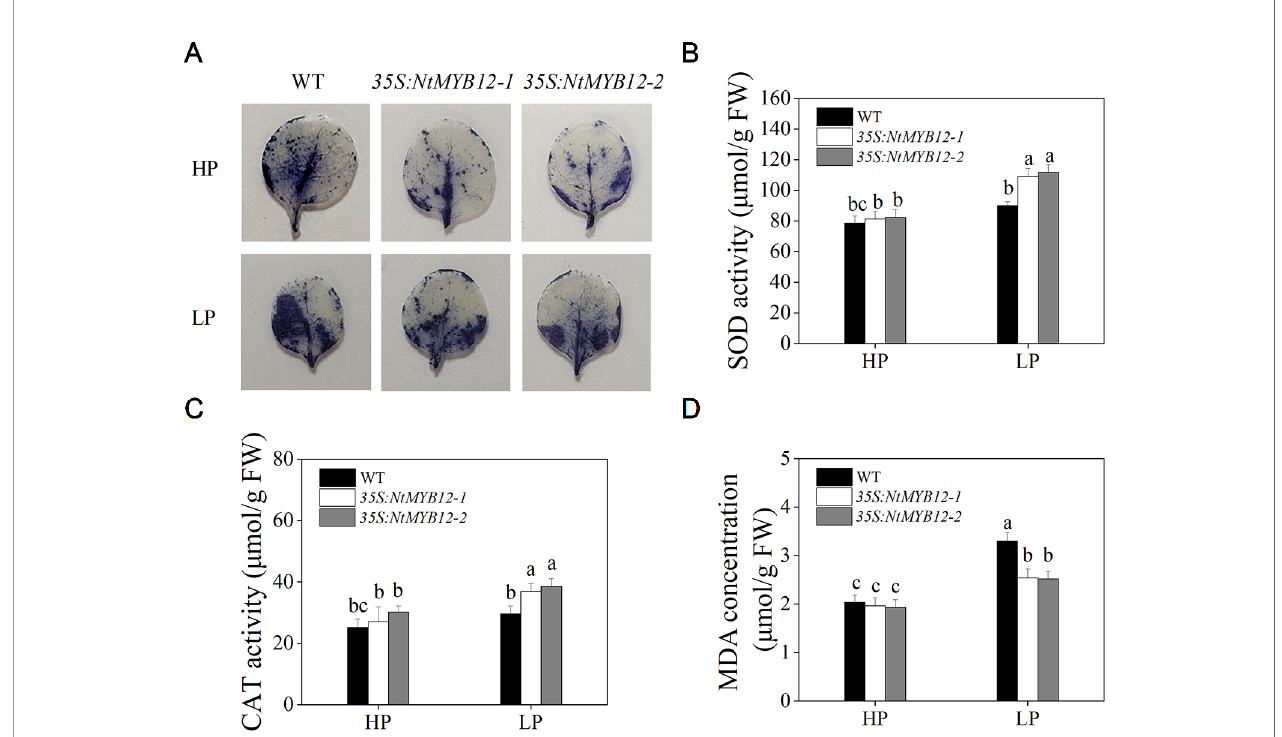
FIGURE 5 | Effects of P treatment on antioxidant enzymes of WT and transgenic tobacco leaves. (A) Detection of Superoxide (O 2 -) by NBT staining in tobacco seedlings. (B) SOD activity of the WT and transgenic plants. (C) CAT activity of the WT and transgenic plants. (D) MDA concentration of the WT and transgenic plants. Sixteen-day-old seedlings were transferred to the full-strength culture solution and supplied with high Pi (HP; 1mM Pi) or low Pi (LP; 0.02mM Pi) for 21 days. FW, fresh weight. Data are the means ± SDs of fi ve biological replicates. Different letters indicate signi fi cant differences ( P <